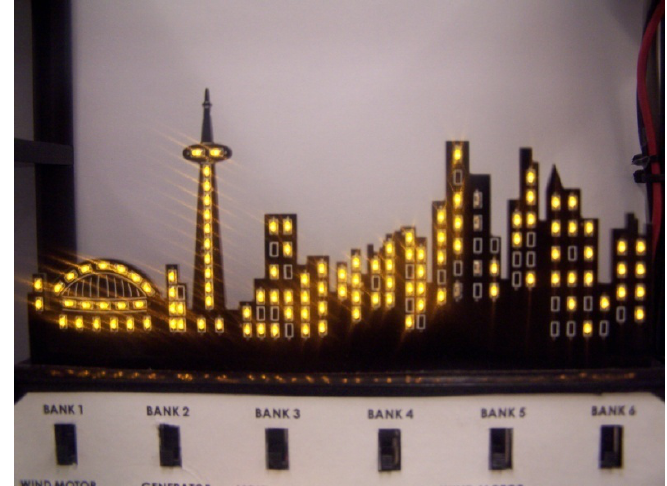
Figure 3. Configuration of the load